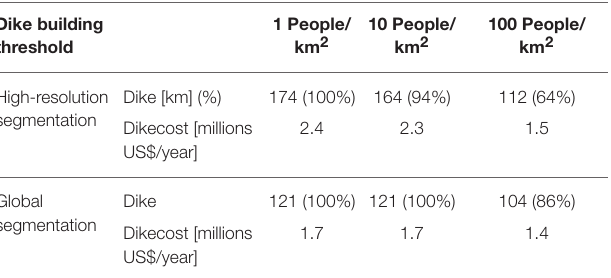
TABLE 5 | Protected coastline length and cost of dikes for different dike construction thresholds using two different assessment scales in 2100 (medium